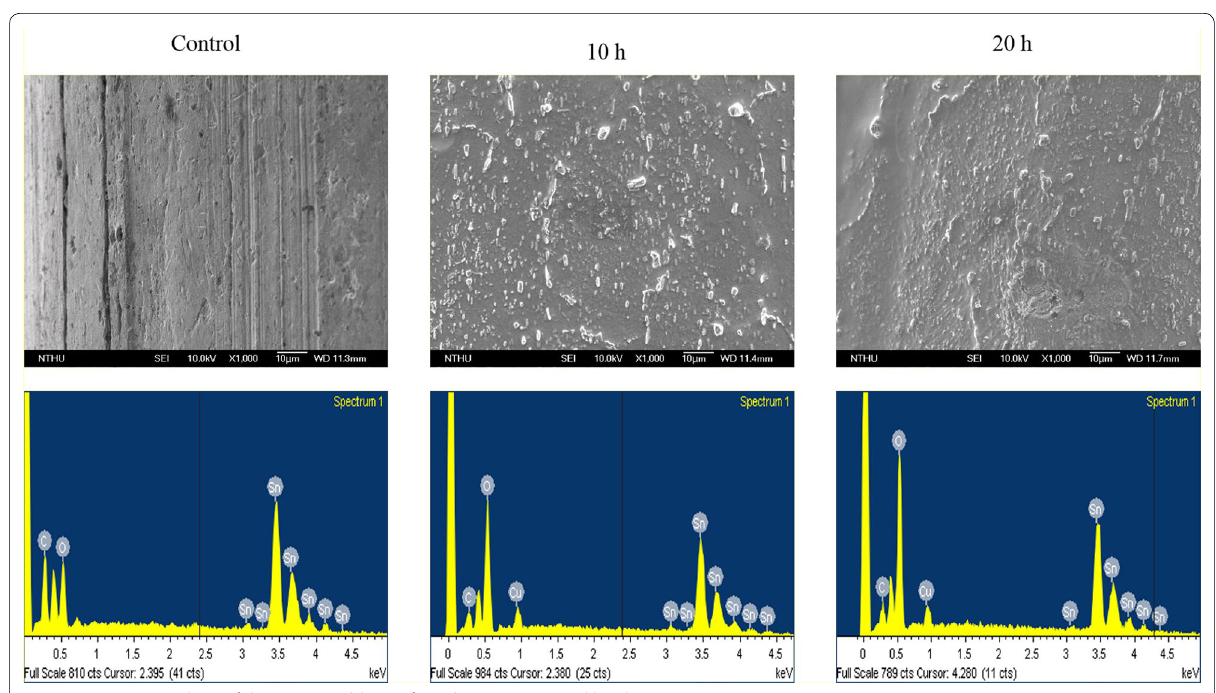
Fig. 8 SEM-EDS analysis of the Sn–Cu solder surface during acetic acid leaching